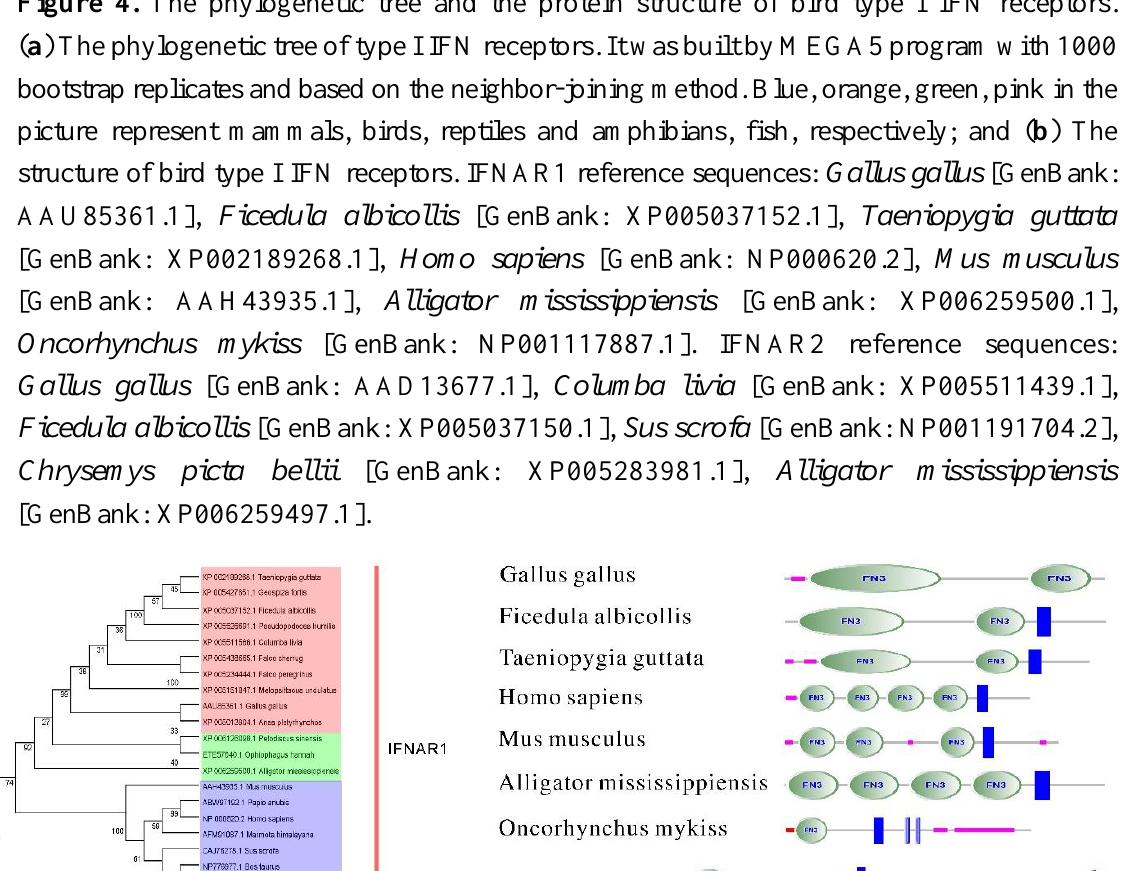
Figure 4. The phylogenetic tree and the protein structure of bird type I IFN receptors. ( a ) The phylogenetic tree of type I IFN receptors. It was built by MEGA5 program with 1000 bootstrap replicates and based on the neighbor-joining method. Blue, orange, green, pink in the picture represent mammals, birds, reptiles and amphibians, fish, respectively; and ( b ) The structure of bird type I IFN receptors. IFNAR1 reference sequences: Gallus gallus